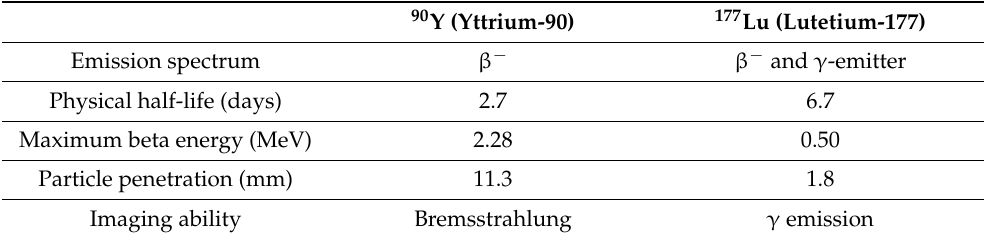
Table 3. Physical properties of 90 Y and 177